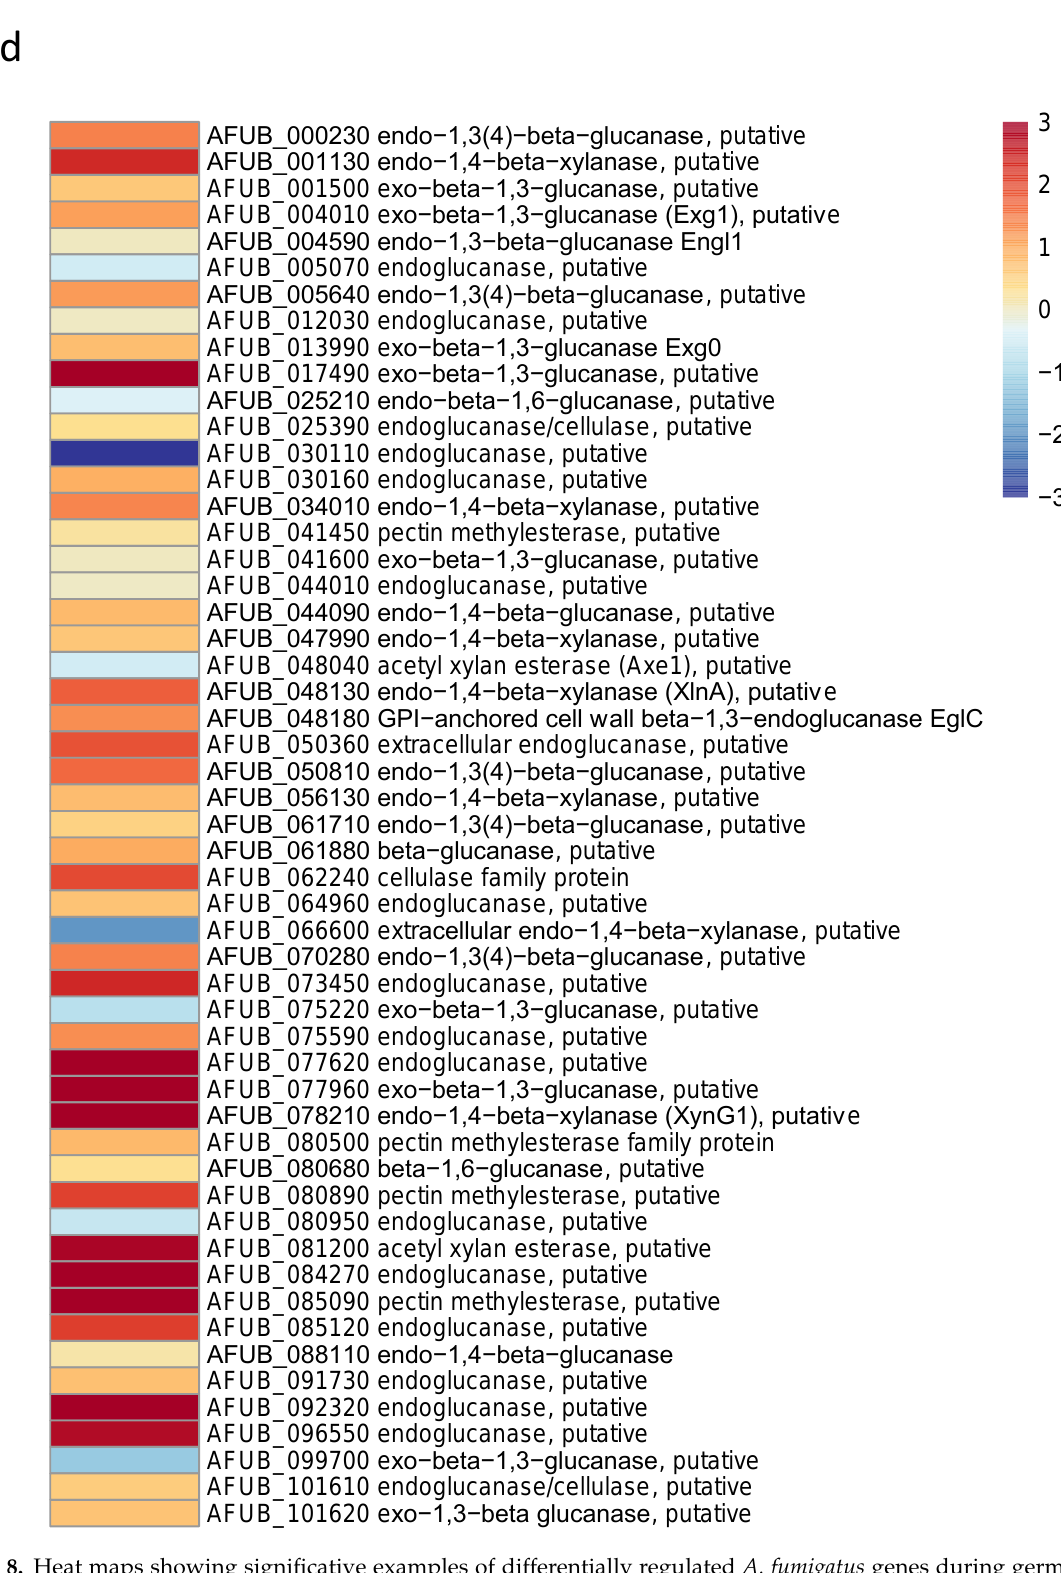
Figure 8. Heat maps showing significative examples of differentially regulated A. fumigatus genes during germination in GAP and MM media. Level of expression of genes for a ratio GAP/MM: ( a ) down regulation of ergosterol synthesis and upregulation of trehalose synthesis suggesting the entrance in quiescence of conidia germinating in GAP medium; ( b ) ribosome and protein synthesis pathways down regulated in absence of growth in GAP medium; ( c ) Down regulation of cell wall synthases and up regulation of autolytic cell wall glycosyl hydrolases indicating that the germ tubes are starved in GAP medium; ( d ) high expression of genes coding for plant material degrading glycosylhydrolases indicating the starvation status of GAP cells and the attemps to its quest for